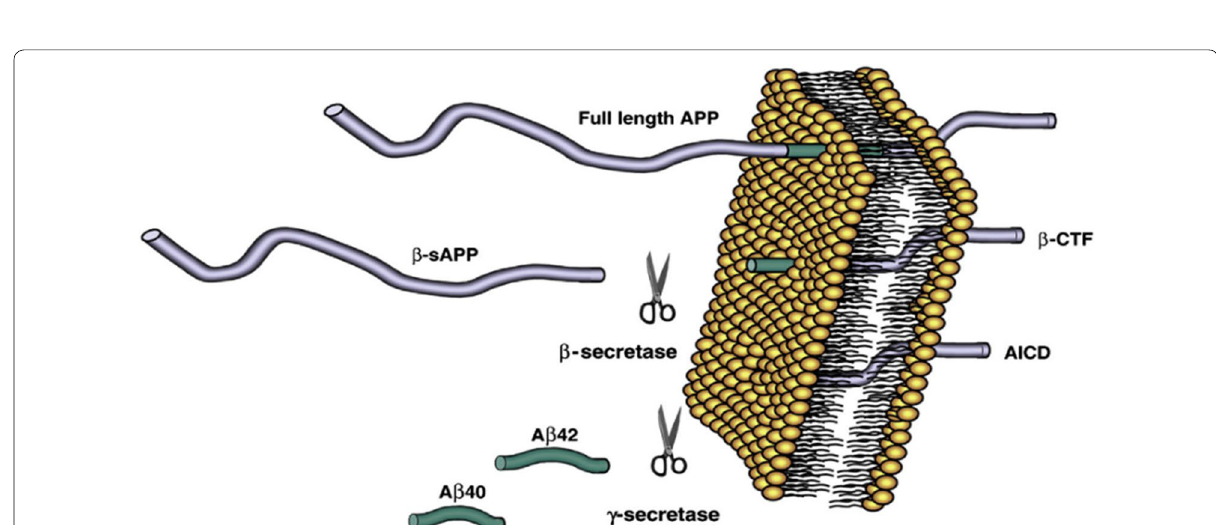
Fig. 2 Generation of soluble Aβ fibrils from amyloid precursor protein